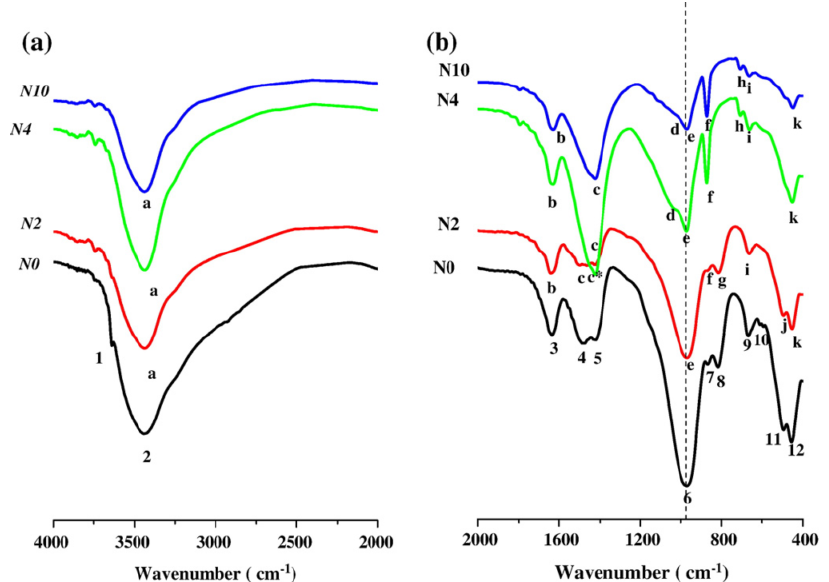
Figure 11. The effect of NiO 2 /SiO 2 on Si-O-T asymmetric vibrations in FTIR for ( a ) OH/HOH and ( b ) Si-O-T bands (From ACS Ref. [45] and used with permission).